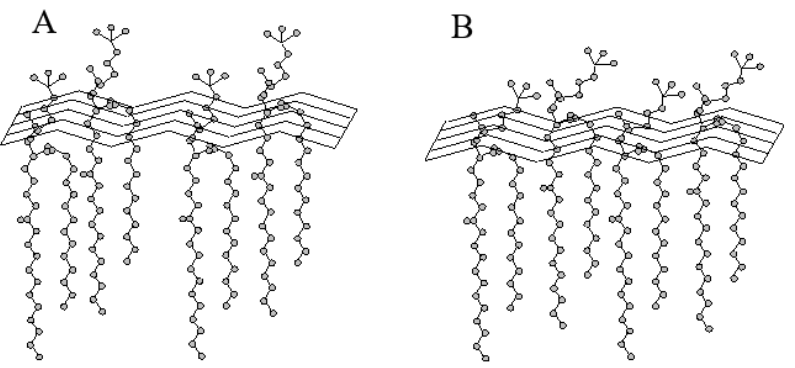
Figure 4. Schematic representation of the polar conformation of the phosphatidylcholine group. ( A ) Conformation with a perpendicular arrangement of the phospholipid heads to the membrane surface, and ( B ) conformation with a parallel arrangement of the phospholipid heads to the membrane surface.